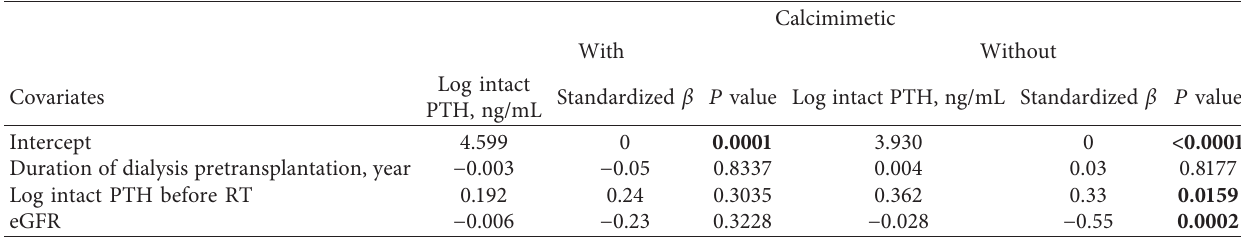
Table 3: Associations between intact PTH after RT and clinical variables by with/without medication of calcimimetic.